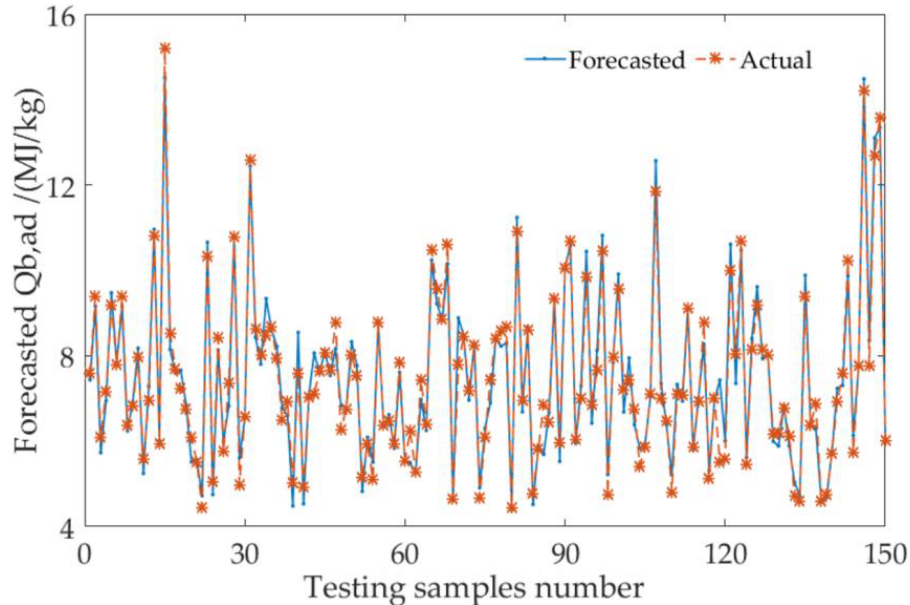
Figure 10. Comparison of actual values and forecasted calorific values based on the hybrid kernel function (where C = 16.98, σ = 1.35, ε = 0.02 and µ = 0.79).